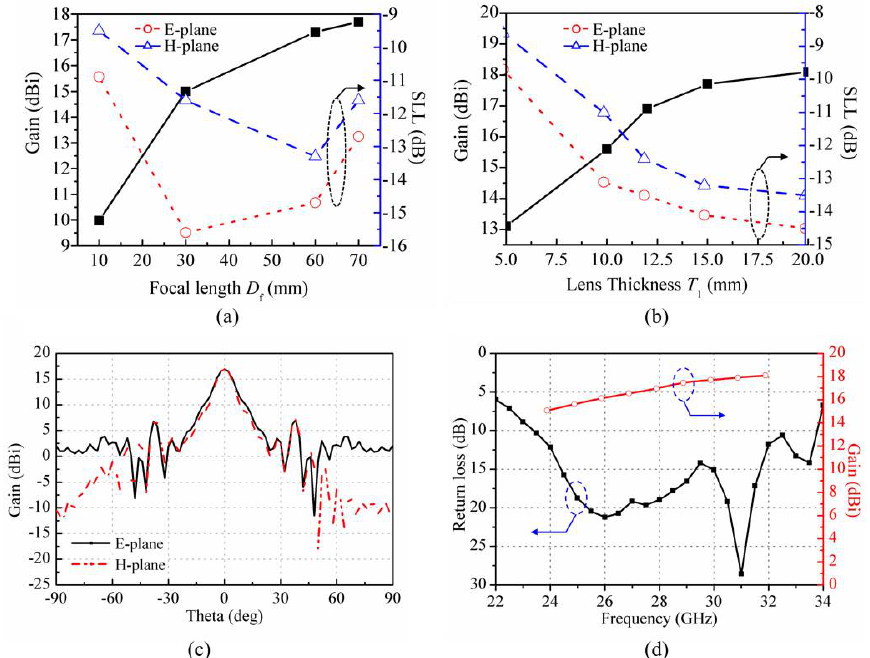
Figure 6. Simulated gain (left axis) and sidelobe level (right axis) of proposed structure at 28 GHz versus ( a ) focal length D f , and ( b ) lens thickness T 1 ; ( c ) Simulated 2D radiation patterns of proposed structure at 28 GHz; and ( d ) return loss (left axis) and gain (right axis).